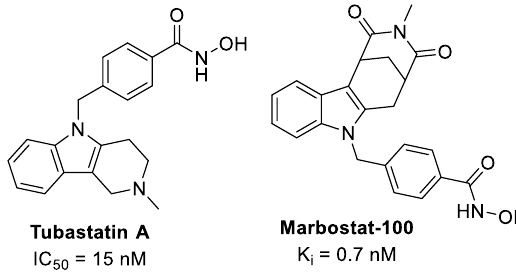
Figure 4. Phenylhydroxamate-based HDAC-6 inhibitors.